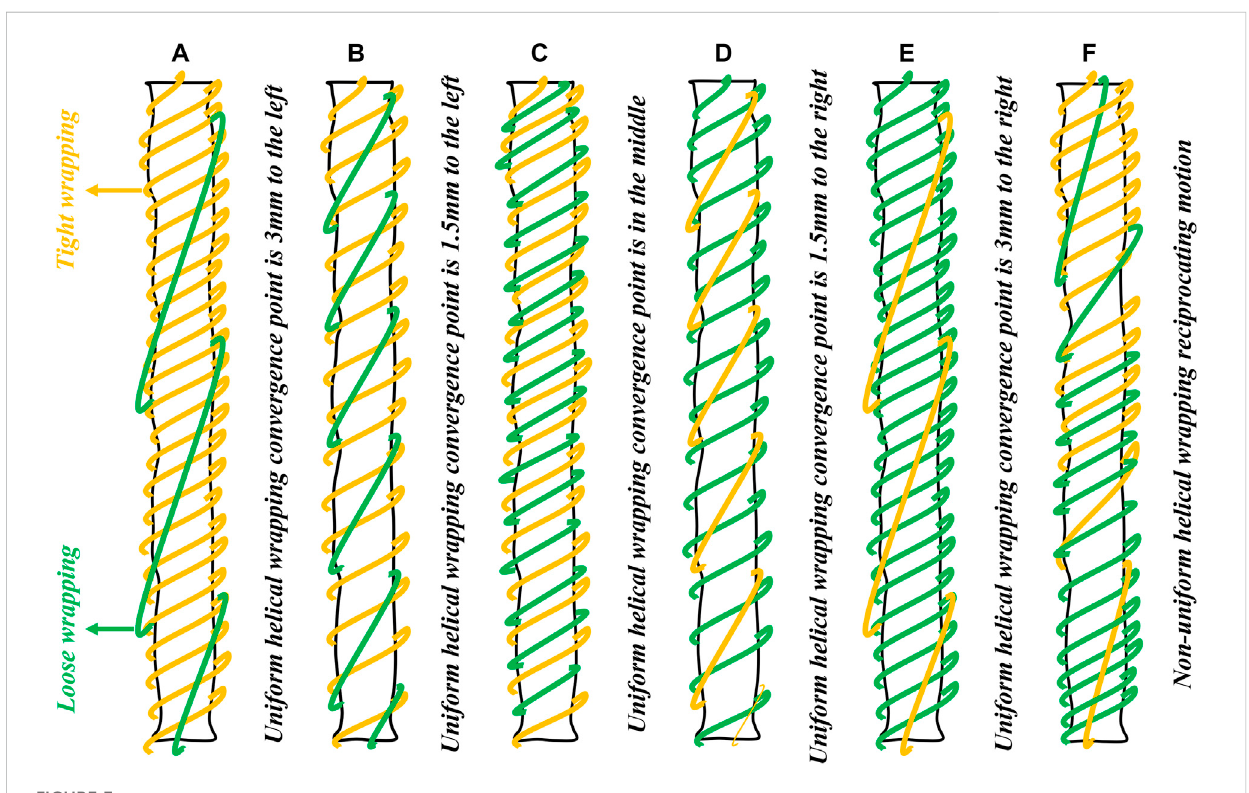
FIGURE 3 Illustration of the variation in the structure of the spiral formed by the compound yarns of the different schemes: (A) CY-A; (B) CY-B; (C) CY-C; (D) CY-D; (E) CY-E and (F) CY-F.